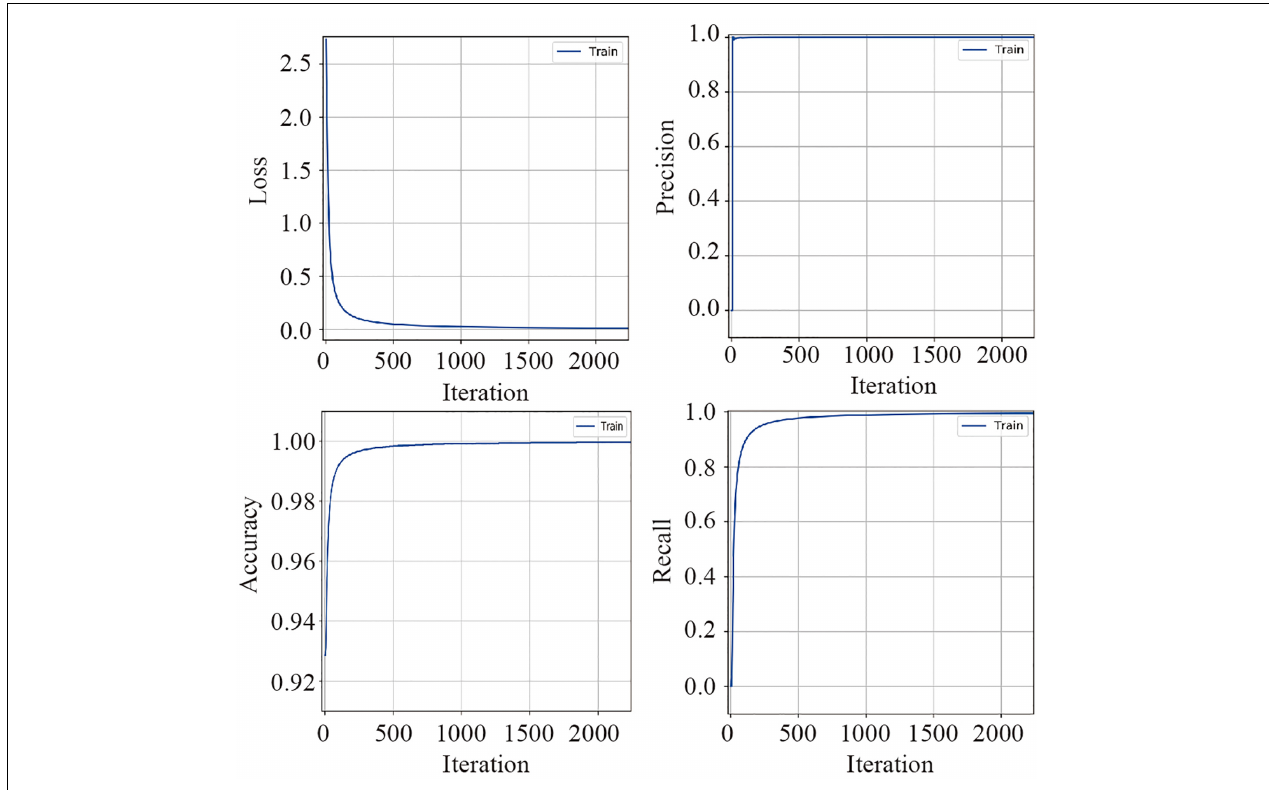
FIGURE 3 | The valuation parameter curves of the CNN model’s training using the validation dataset. The loss, precision, accuracy, and recall curves are plotted according to their values in each